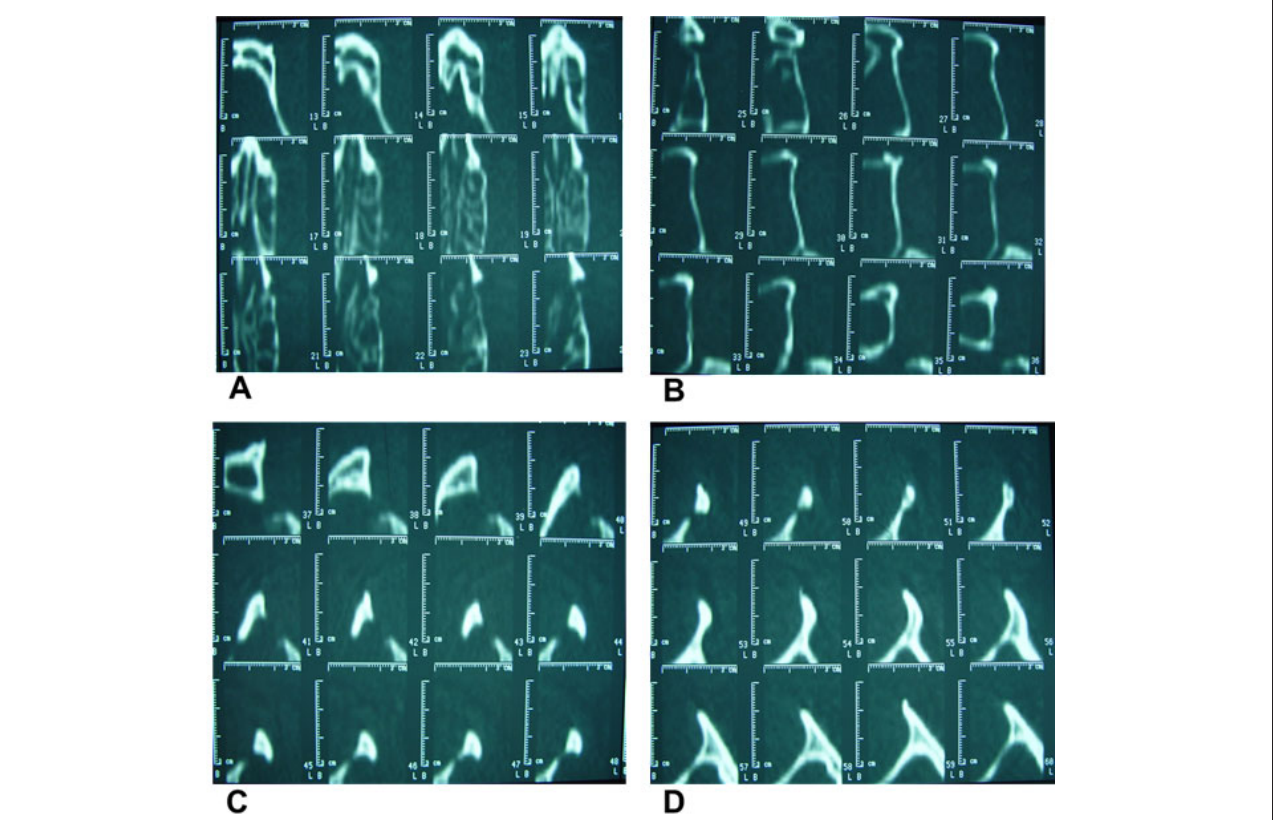
Fig. 3 - Computed tomography scan of the left orbit. Images corresponding to the cross-sectional cuts of the peri-orbital. A - cuts 13 to 24 B; - cuts 25 to 36; C - cuts 37 to 48 D; - cuts 48 to